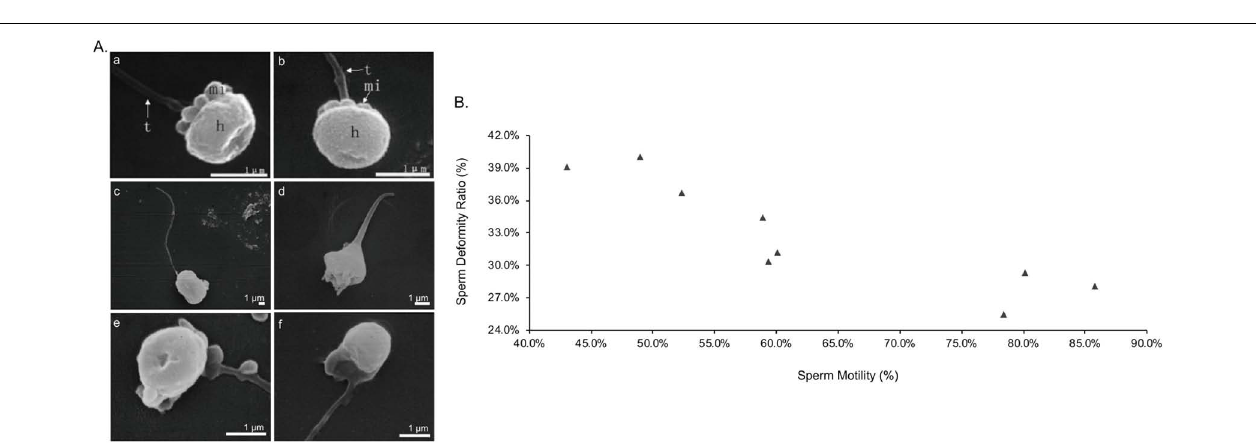
FIGURE 5 | Sperm deformity and sperm motility. (A) Scanning electron microscopy (SEM) assay of turbot sperm. (a,b) Normal sperm; h, head; mi, mitochondria; t, tail (Zhang et al., 2013); (c,d) head abnormalities; (e,f) mitochondria abnormalities. (B) Deformity ratio of sperm with different motility. n = 9.